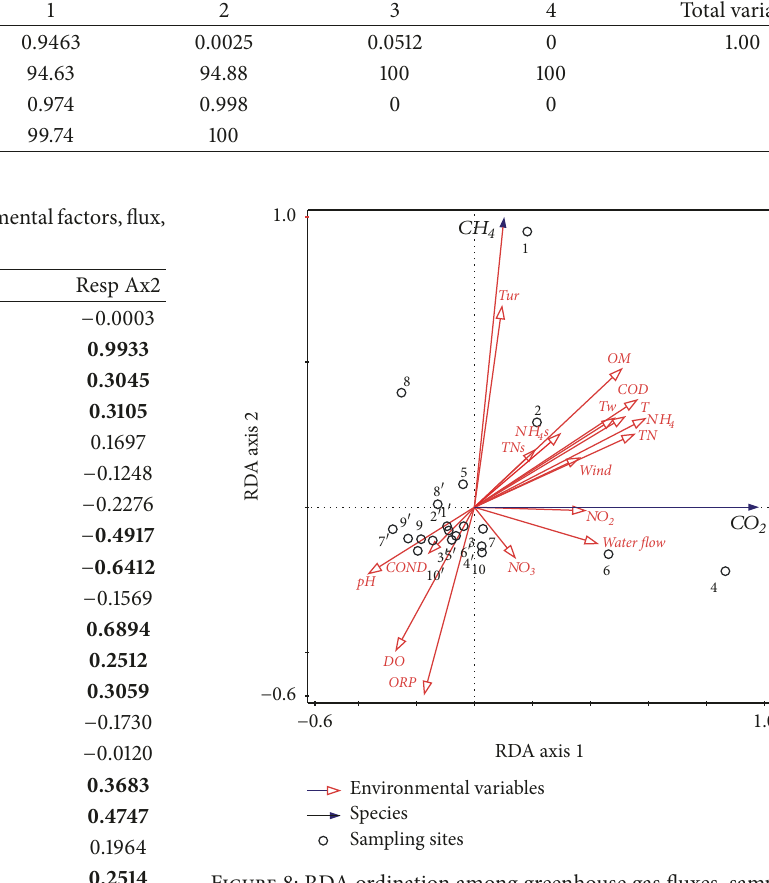
Figure 8: RDA ordination among greenhouse gas fluxes, sampling sites, and environmental factors.